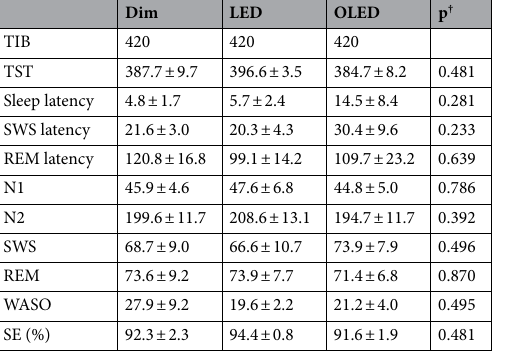
Table 1. Sleep architecture. Sleep parameters indicated as TIB, Time in bed; TST, total sleep time; SWS, slow-wave sleep; REM, rapid eye movement; N1, non-rapid eye movement sleep stage 1; N2, non-rapid eye movement sleep stage 2; WASO, wake after sleep onset; SE, sleep efficiency. Values are mean ± SE in minutes ( n = 10). p † ; one-way repeated measures